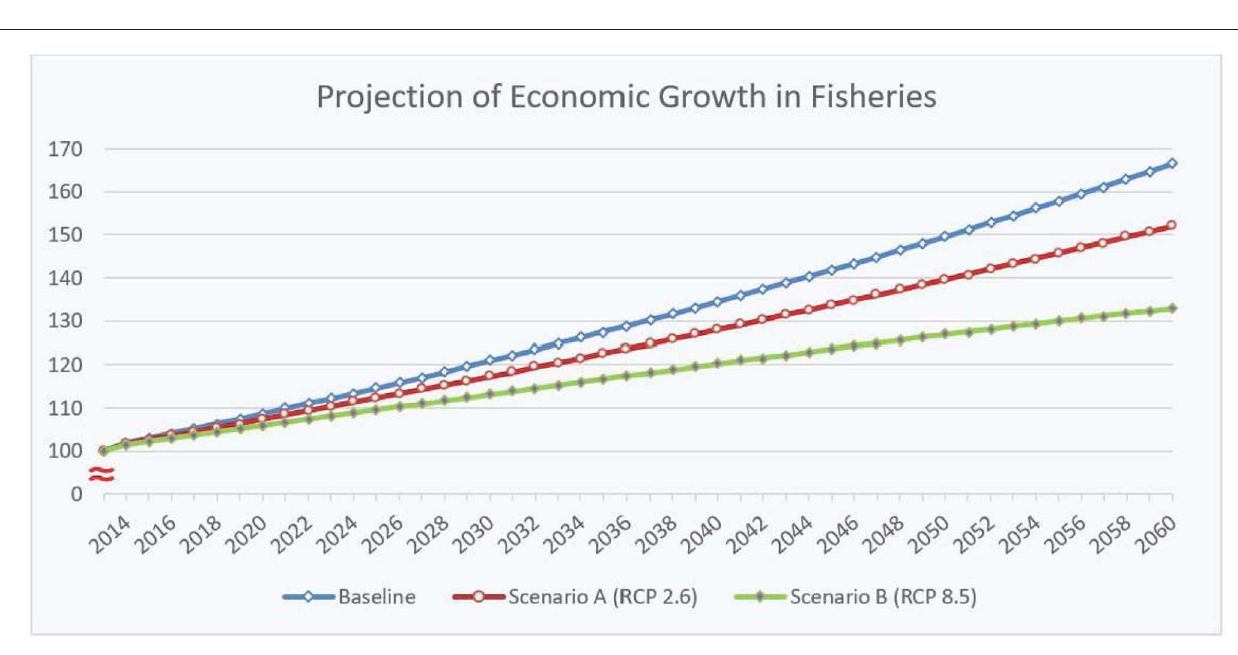
FIGURE 6 | Projection of economic growth in the fisheries by scenario. The GDP in base year is normalized to